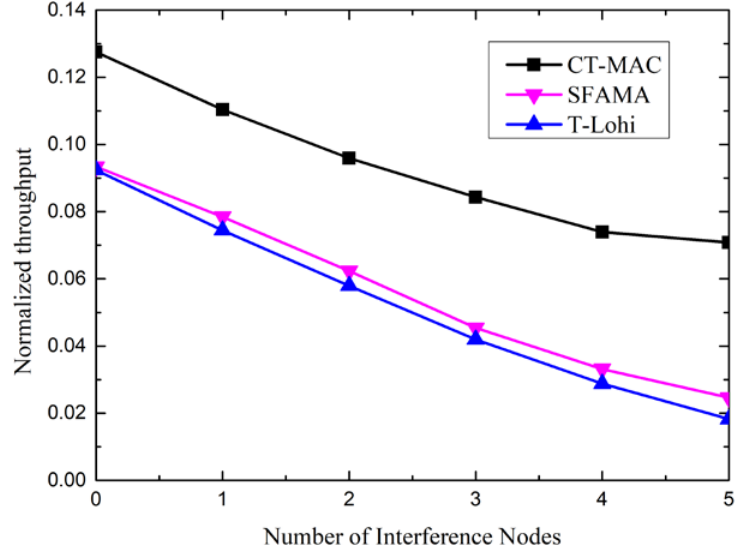
Figure 13. The normalized throughput of the CT-MAC protocol vs. the number of interference nodes .